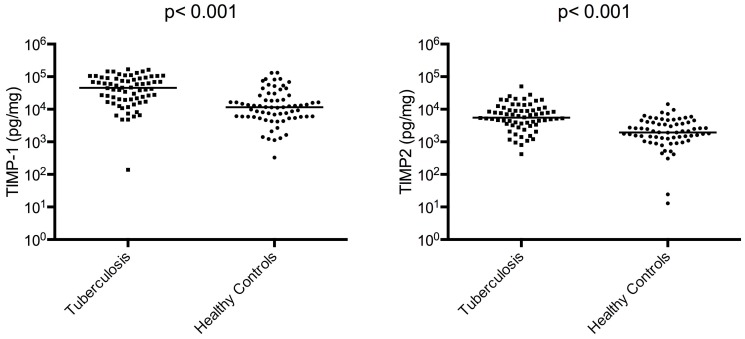
TIMP-1/2 concentrations are elevated in TB patients compared to controls.TIMP-1 and TIMP-2 concentrations are increased in induced sputum from TB patients compared to healthy controls analysed at time of TB diagnosis. The horizontal line is the median value.